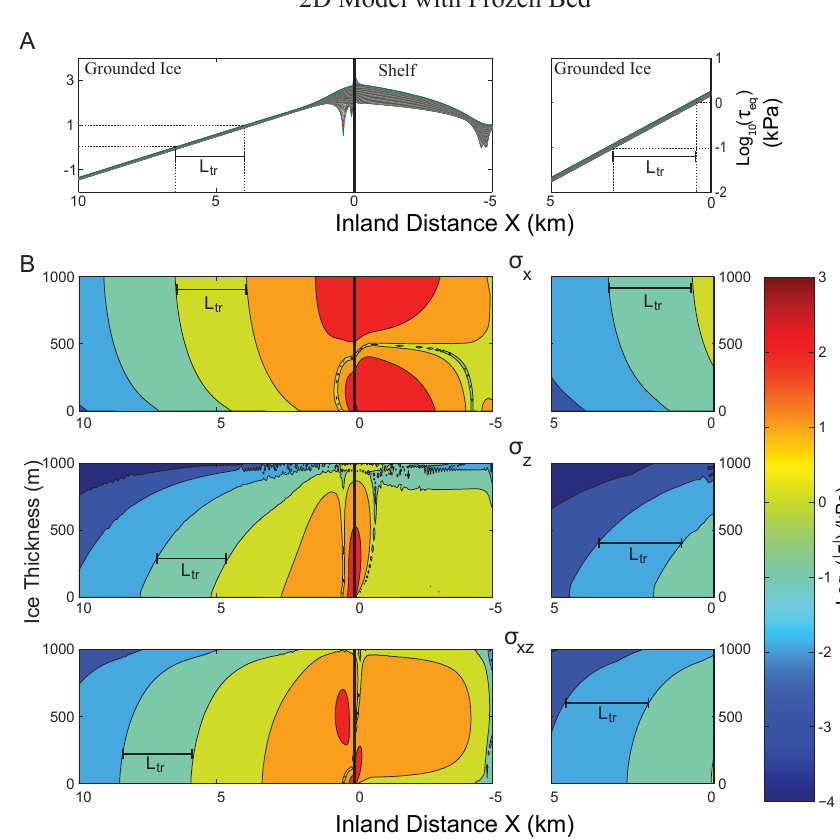
Figure 4. Stress distributions for a 2-D model with a frozen (i.e., no slip) basal condition. The panels are the same as in Fig. 3. Stress at the grounding line is higher in the model with an ice shelf than without a shelf, but L tr is the same between the two model